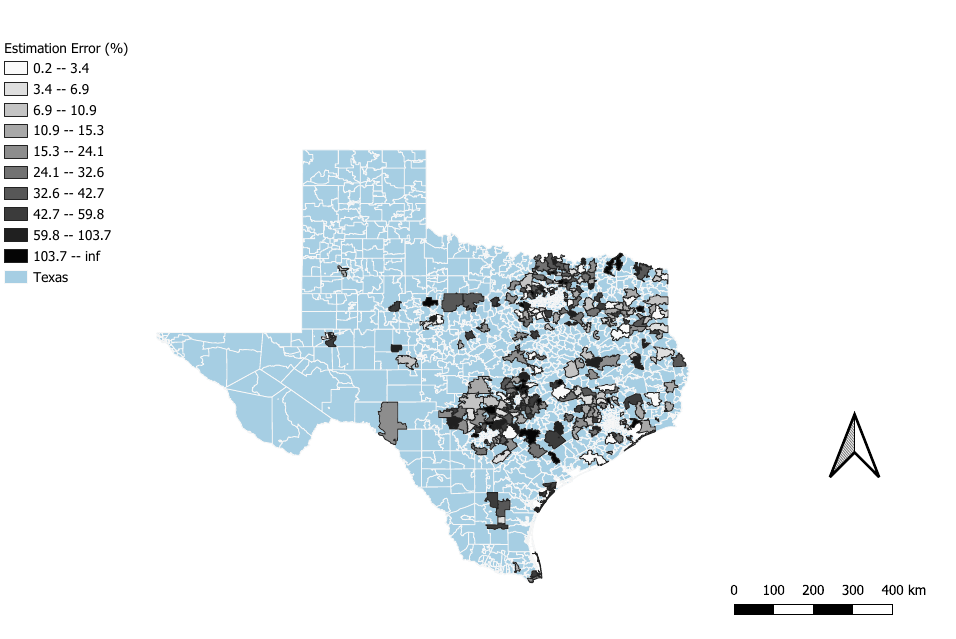
Figure 5. Map of DNN ihpAmount estimation error